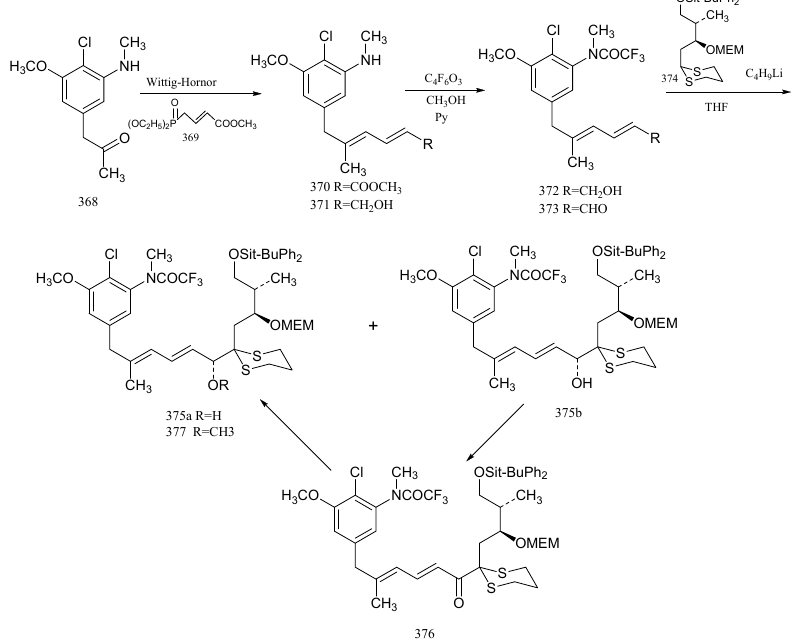
fragment ( 377 ) of maytansine (Figure 23).